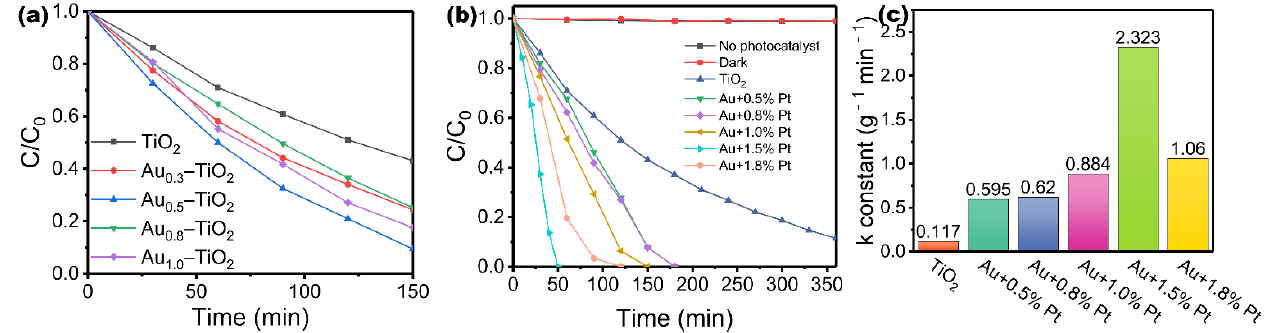
Figure 3. Under (UV – vis) light irradiation, ( a ) ethylene photodegradation curves of Au – TiO 2 with different Au ratios, ( b ) ethylene photodegradation curves and ( c ) reaction rate constants of AuPt – TiO 2 with different Pt ratios.